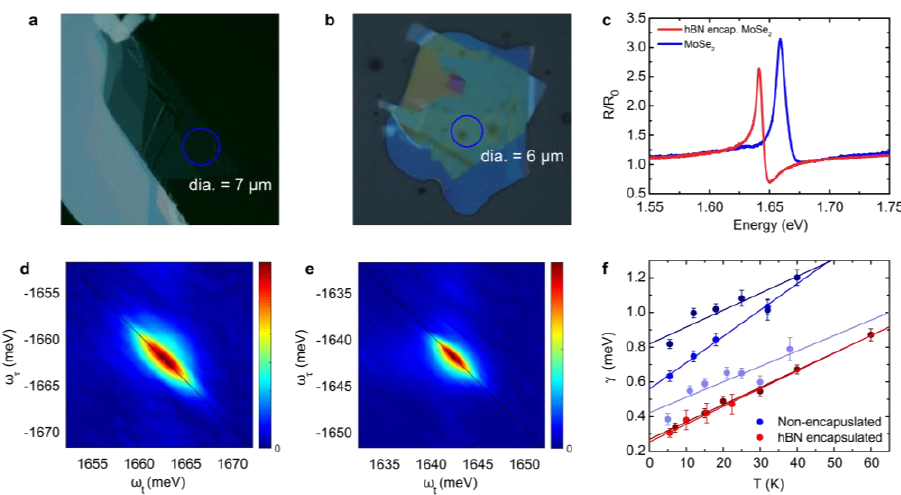
Figure 1: a Optical image of mechanically exfoliated MoSe 2 flake on sapphire. b Image of boron nitride encapsulated MoSe 2 on sapphire having a <6 μm area for measurement. c Linear reflectivity measurements reveal narrowing of the linewidth with encapsulation and can be used to estimate the oscillator strength of the resonance. Linear measurements cannot be used to determine the homogeneous linewidth. d MDCS is used to extract the homogeneous linewidth (roughly the cross- diagonal linewidth) of MoSe 2 on sapphire in the presence of inhomogeneity (evidenced by the resonance broadening along the diagonal). e MDCS measurement of encapsulated MoSe 2 reveals a narrowing of both the homogeneous and inhomogeneous linewidths. f MDCS measurements are made for a range of excitation densities at each plotted temperature. Therefore each point indicates the extrapolated zero-power linewidth for removing exciton-exciton scattering. We fit these points to extrapolate to the zero-temperature linewidth for removing exciton-phonon scattering. Blue points indicate non-encapsulated samples, where each shade of blue corresponds to a different sample. Red points indicate encapsulated